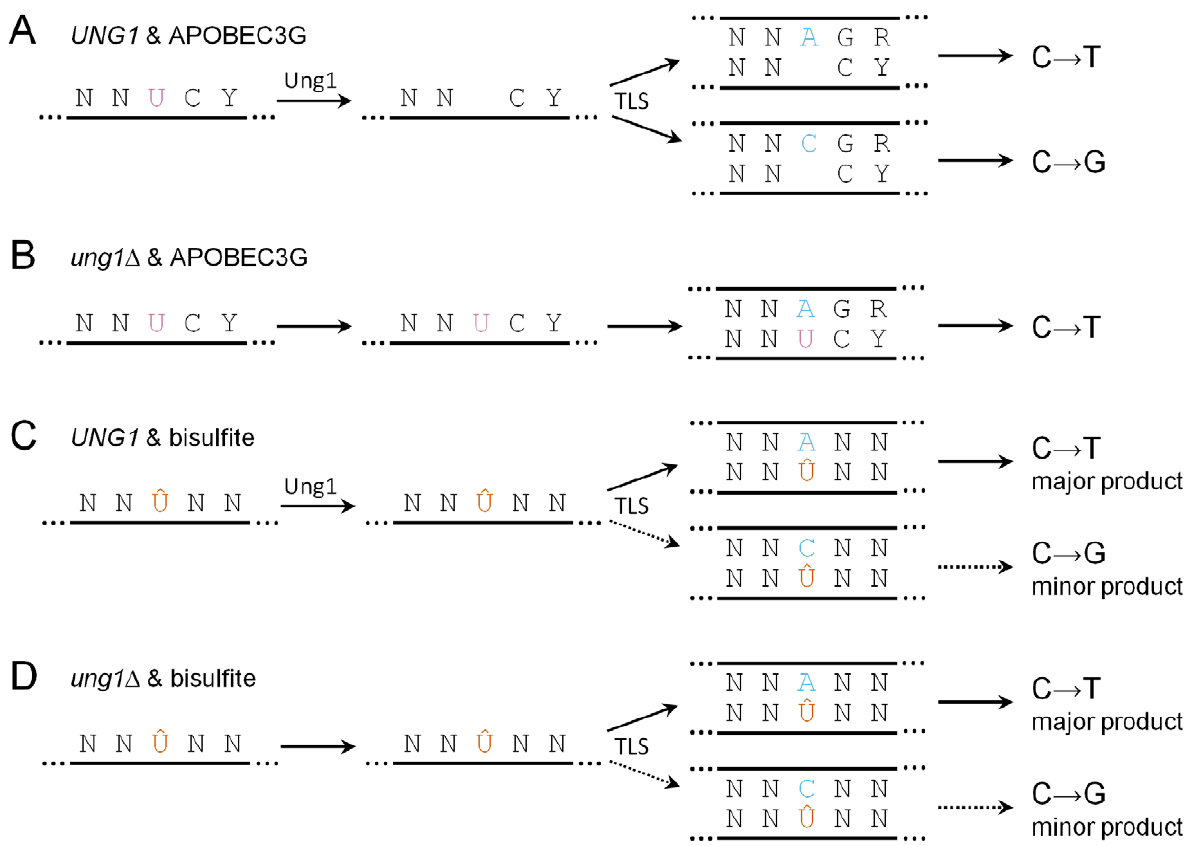
Figure 7. Summary of the possible fates of deaminated cytosine. Y denotes pyrimidine, R denotes purine, and N denotes any base. (A) In UNG1 cells expressing APOBEC3G, uracil resulting from cytosine deamination (frequently at 5 9 -YCC-3 9 motifs) is excised efficiently by Ung1. During repair synthesis, TLS inserts adenine or cytosine opposite abasic sites, resulting in similar frequencies of C R T transitions and C R G transversions. (B) In ung1 D cells, uracil persists. During repair synthesis, adenine is inserted opposite uracil, resulting in all C R T transitions. (C) In UNG1 cells treated with bisulfite, 5,6-dihydrouracil-6-sulfonate (denoted as Uˆ) persists because of inefficient excision. During repair synthesis, TLS usually results in insertion of adenine opposite 5,6-dihydrouracil-6-sulfonate, while insertion of cytosine occurs infrequently. (D) In ung1 D cells, 5,6-dihydrouracil-6- sulfonate also persists, resulting in similar mutagenic outcomes as UNG1 cells.